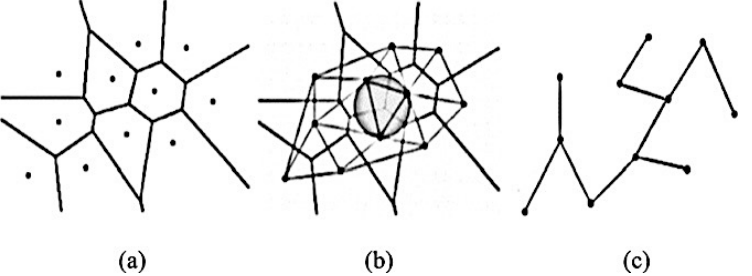
Figure 10. Types of graph-based topological features illustrated as ( a ) Voronoi diagram, ( b ) Delaunay graph triangulation, ( c ) minimum spanning tree [102].